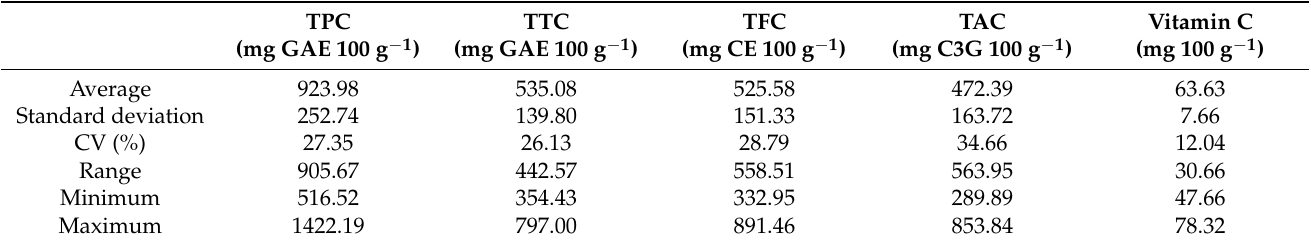
Table 2. Descriptive statistics for honeyberry total phenolic (TPC), tannin (TTC), flavonoid (TFC), anthocyanin (TAC), and vitamin C